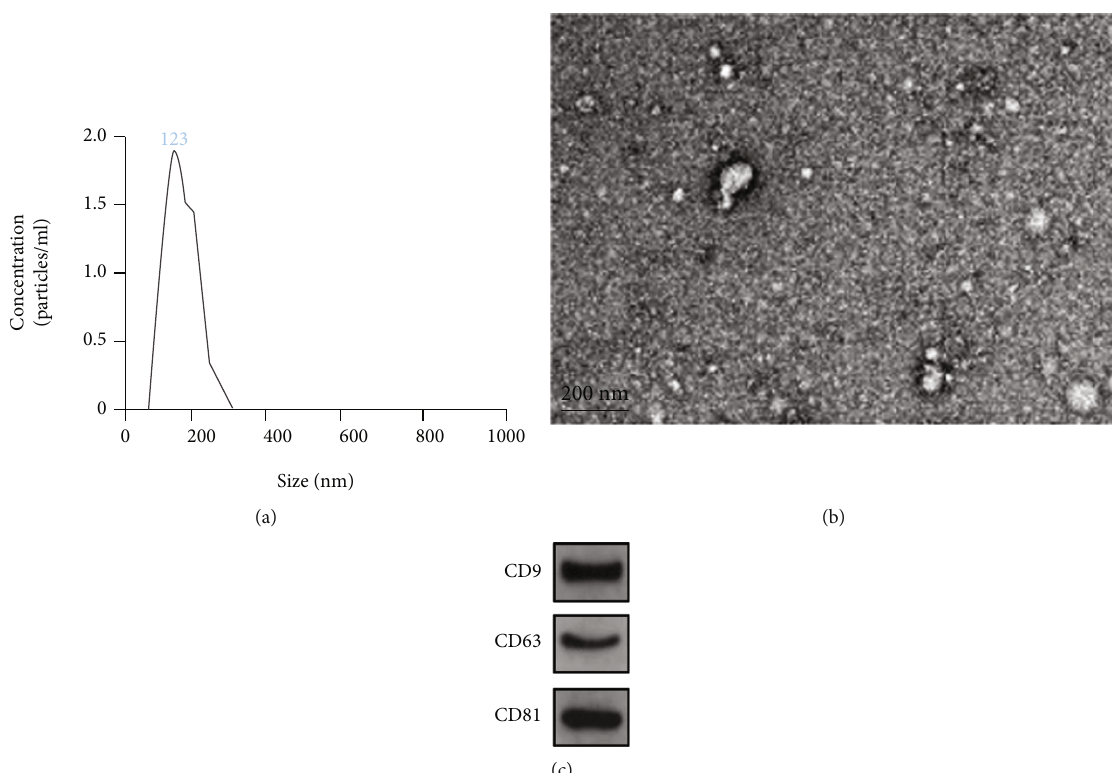
Figure 1: Identi fi cation of exosomes by NTA, TEM, and Western blot. (a) NTA was used to determine the diameter distribution of extracted exosomes at about 123nm; (b) the morphology of exosomes was observed by TEM; (c) exosome marker proteins CD9, CD63, and CD81 were detected by Western